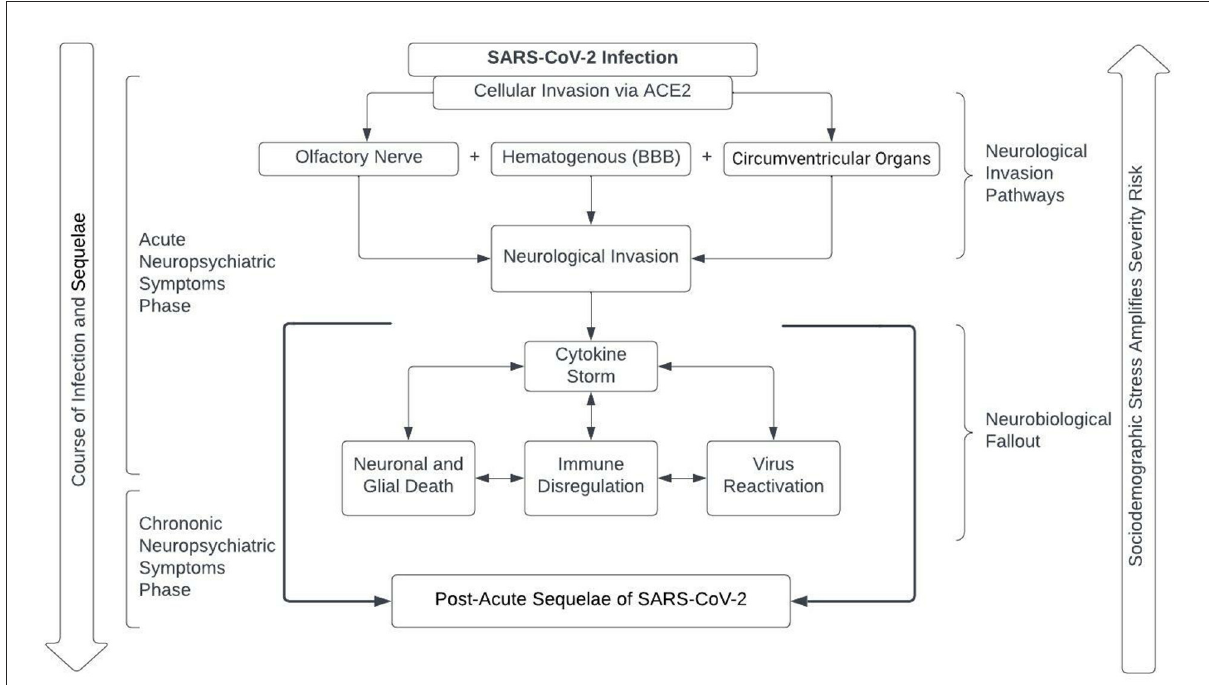
FIGURE1 Potential etiology of COVID-19 neuropsychiatric symptoms. Following infection with SAR-CoV-2 there are several mechanisms that can potentially lead to a viral neurological invasion. The subsequent neurological invasion increases the already present cytokine storm leading to a feedback loop of biological consequences including neuronal/glial death, immune dysregulation, and virus reactivation; consequences that may potentially worsen symptomology of infection. The fallout of neurological invasion may account, at least in part, for chronic symptomology. Additionally, the risk and severity of the discussed fallout may be amplified by sociodemographic